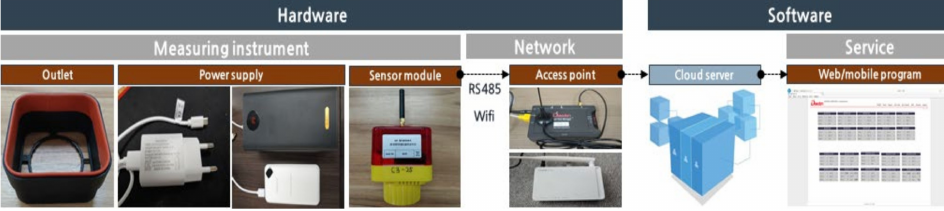
Figure 7. CPMS network composition.